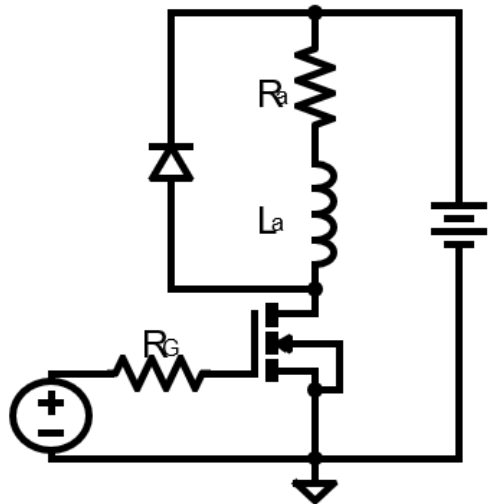
Figure 23. Inductive load control circuit with a flyback diode.